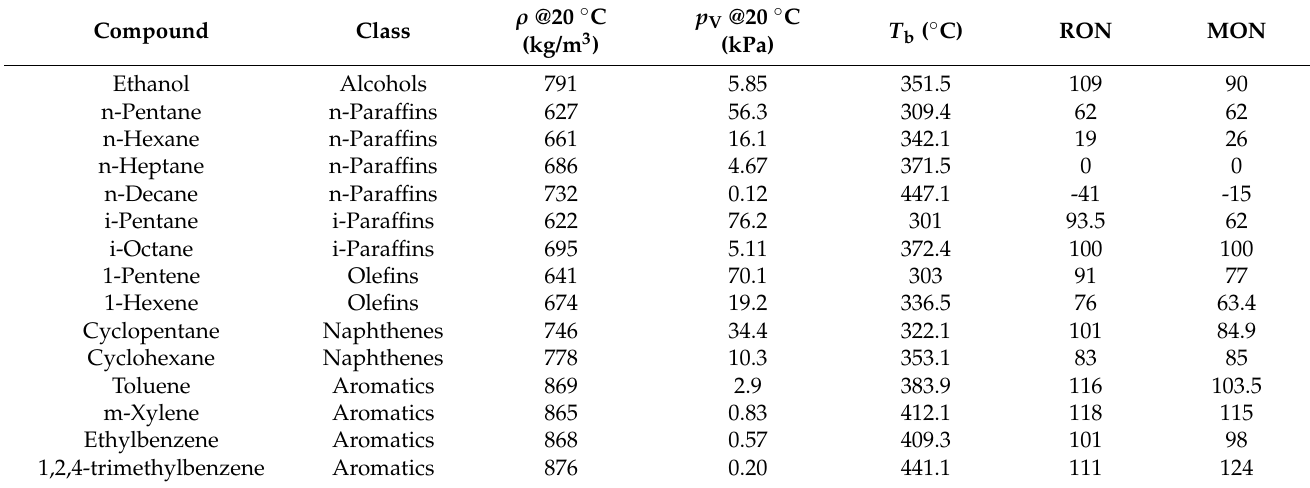
Table 1. Palette of the selected pure compounds and their